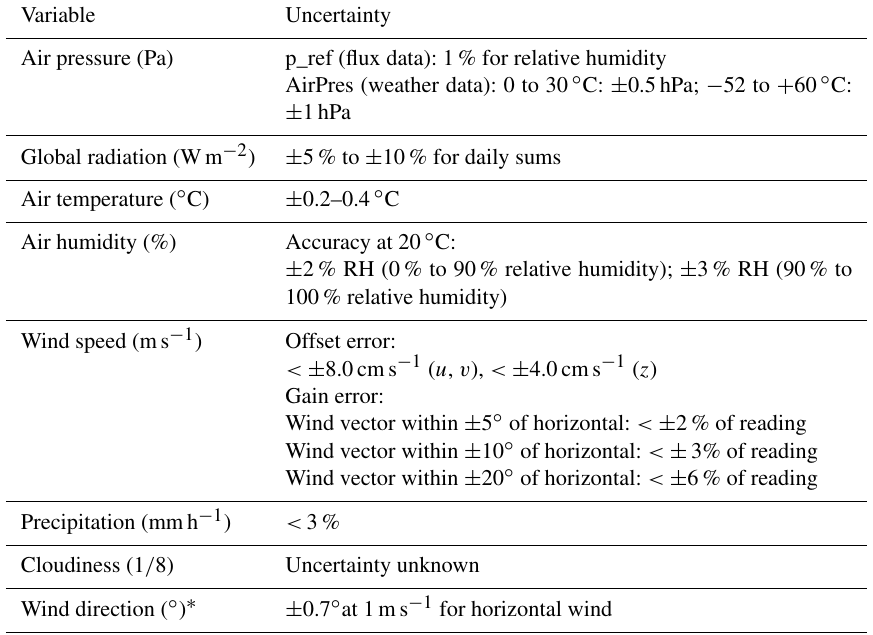
Figure 7. Breaks in time series of meteorological measurements. (a) Air pressure in Selhausen, (b) air humidity in Hürtgenwald. Table 11. Instrument uncertainties for meteorological measurements at stations 1 to 21 and 25 (for station IDs see Table 9).